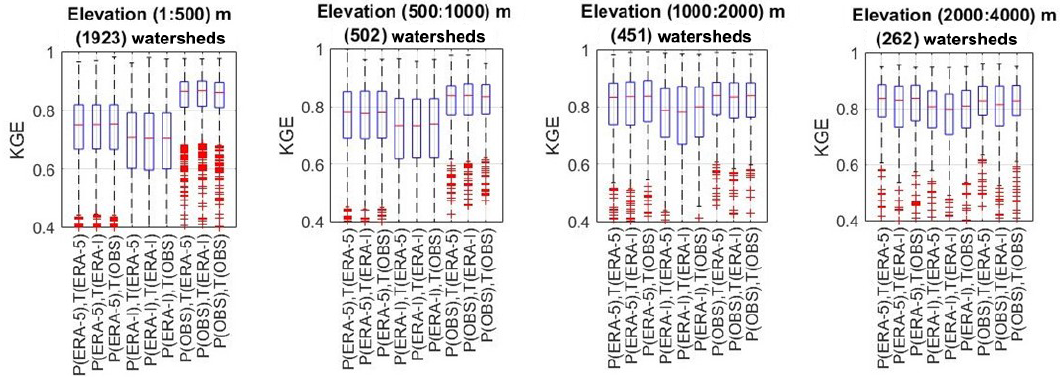
Figure 8. Distribution of the Kling–Gupta efficiency metrics for various elevation bands, for hydrological model HMETS.